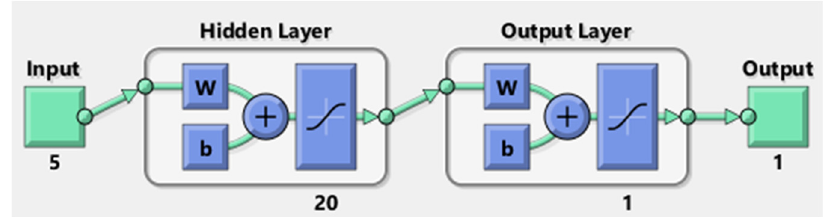
Figure 6: The arti fi cial neural network architecture with the most successful